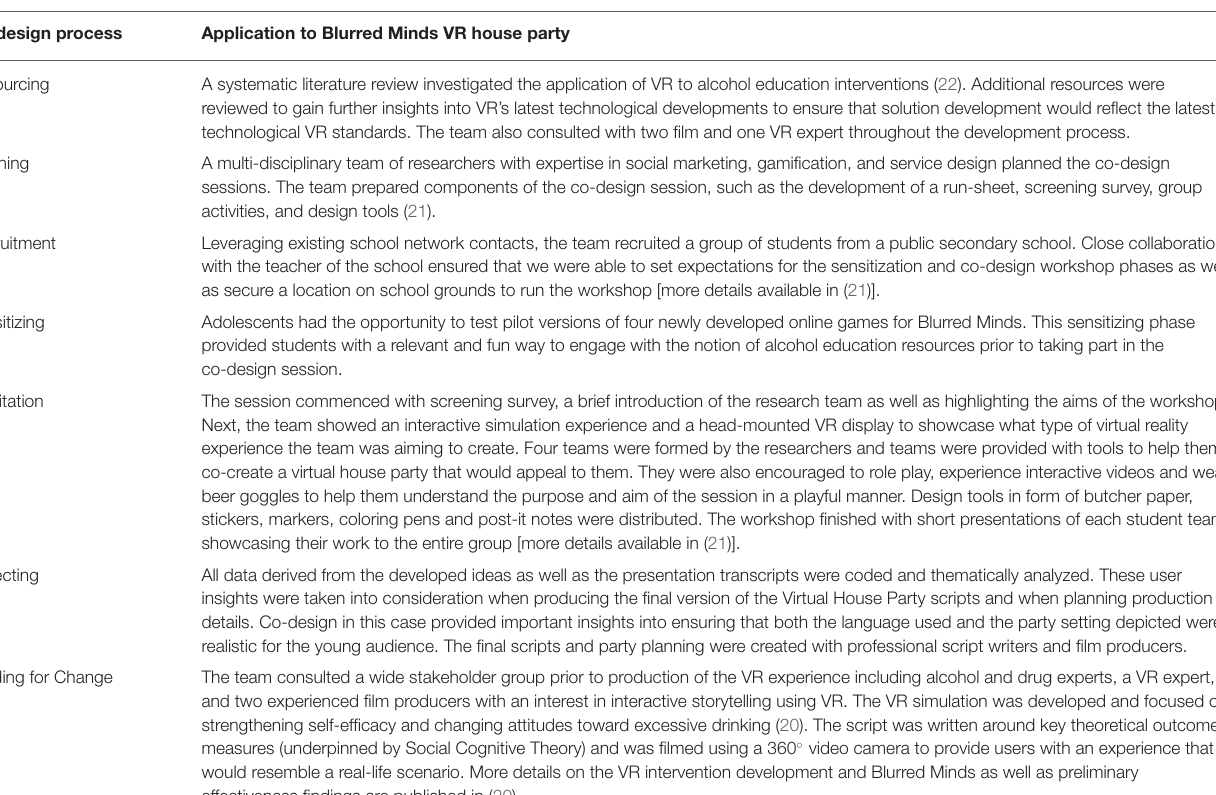
TABLE 1 | Co-designing the Blurred Minds VR House